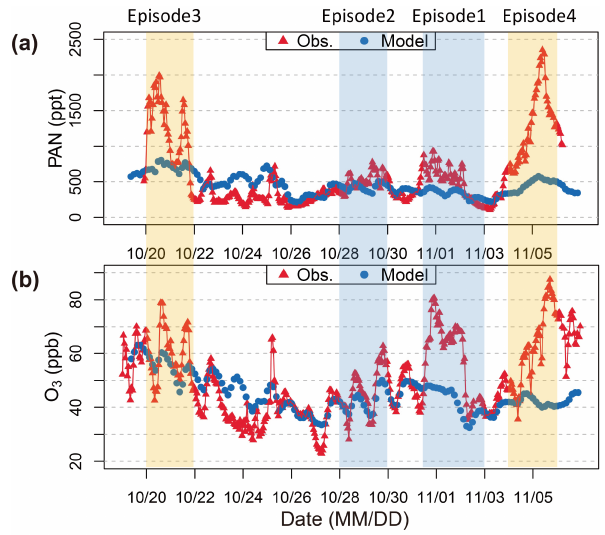
Figure 7. Comparison between the observed and calculated (a) PAN and (b) O 3 concentrations by CAM-chem model. Time is given in local time and the four episodes are